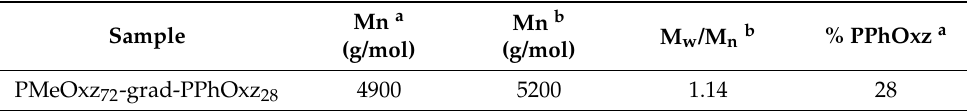
Table 1. Molecular characteristics of the PMeOxz 72 -grad-PPhOxz 28 GC.